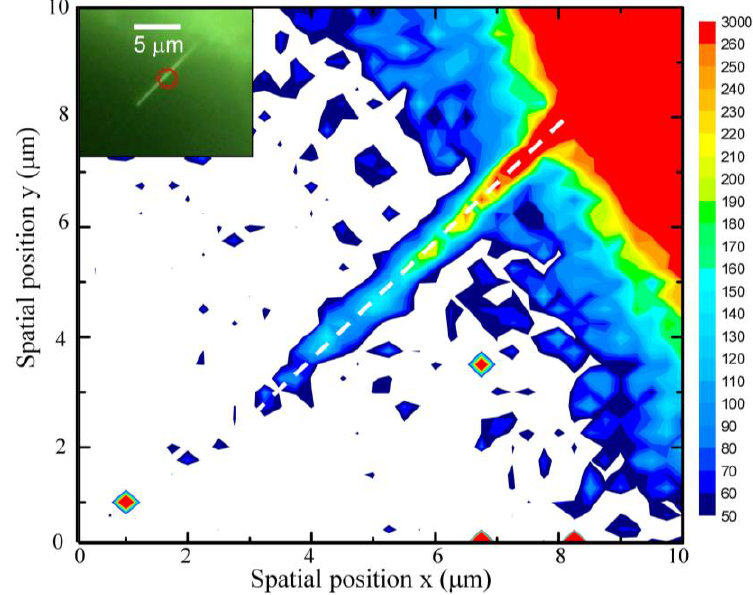
Figure 5. Raman intensities mapping of the E 2H peak ranging from 410 to 460 cm −1 and (inset) the corresponding optical image.